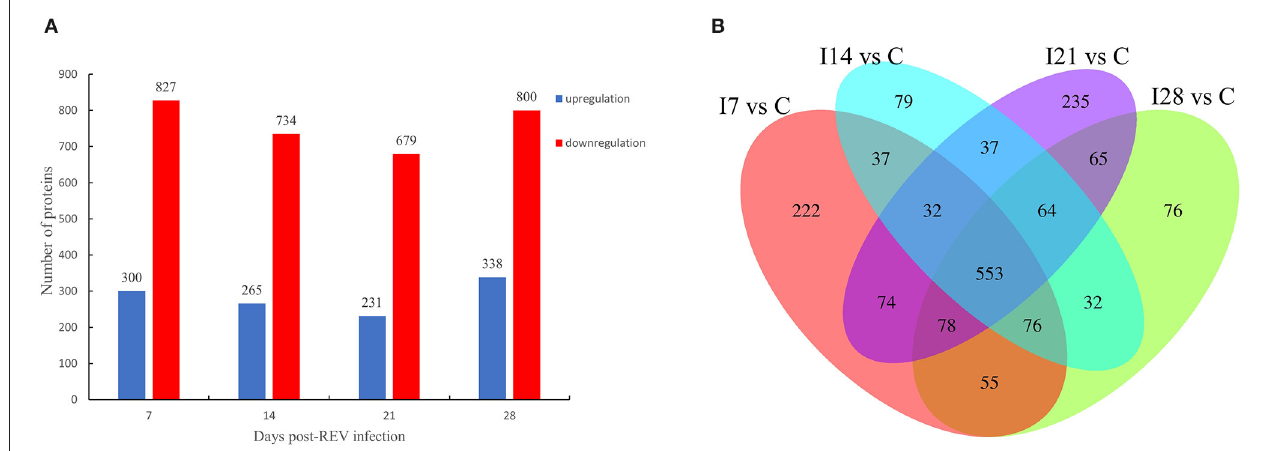
FIGURE 2 | Differentially expressed proteins from chicken bursa of Fabricius infected with reticuloendotheliosis virus (REV). (A) Significant and differentially expressed proteins during infection with REV relative to the control group ( p < 0.05, fold change > 1.3 or < 1/1.3). (B) Venn diagram displays the distribution of differentially expressed proteins during REV infection.